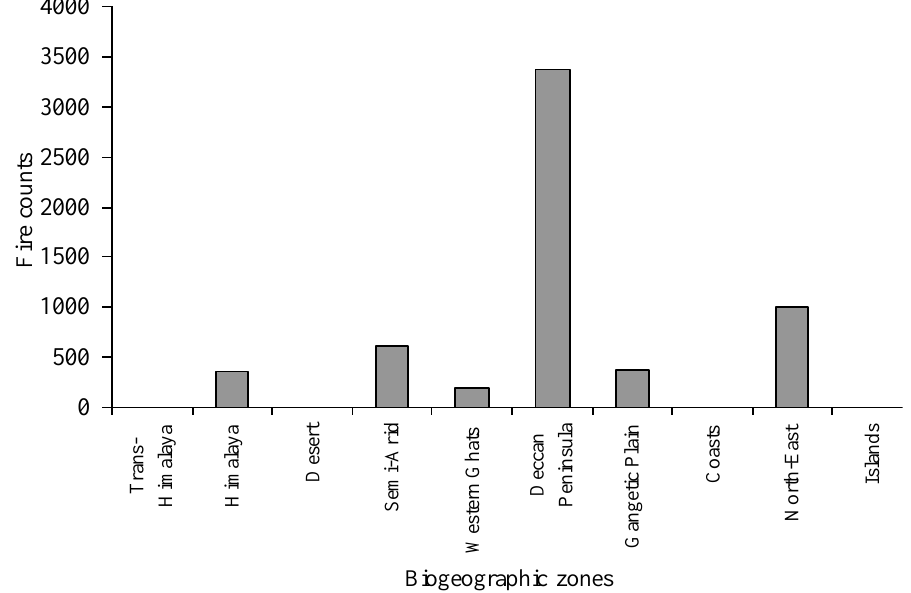
Figure 5. Distribution of fire occurrence across bio-geographic zones using A(A)TSR night-time